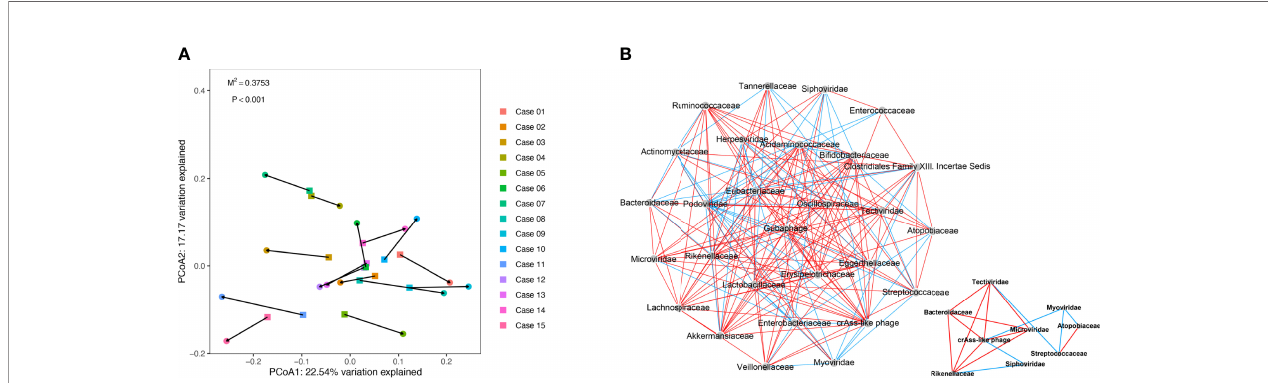
FIGURE 2 | Procrustes analysis and Co-occurrence network analysis between virome and bacteriome in COVID-19. (A) Procrustes analysis of the correlation between viral and bacterial communities of COVID-19 patients. (B) Co-occurrence network analysis between virome and bacteriome. Each nodes represents virus and bacteria on family levels. Edges represented positive associations (red) and negative associations (green) between virus and bacteria. The cutoff of the Spearman correlation and p-value were set at 0.3 and 0.05, respectively.